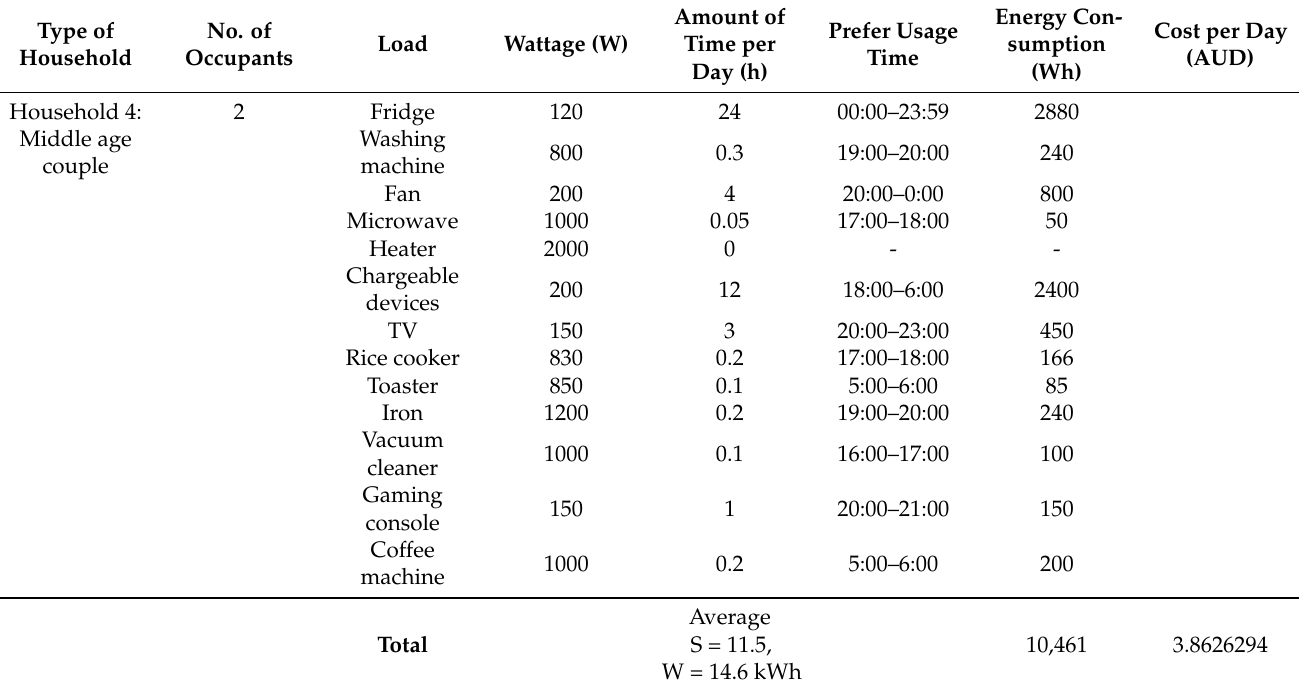
Table 6. Initial load profile 4 created for the project